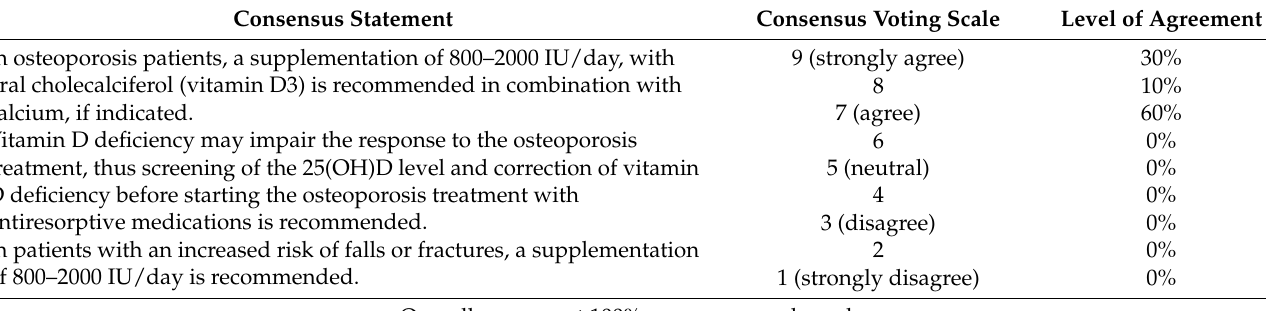
Table 7. Statement regarding vitamin D in musculoskeletal